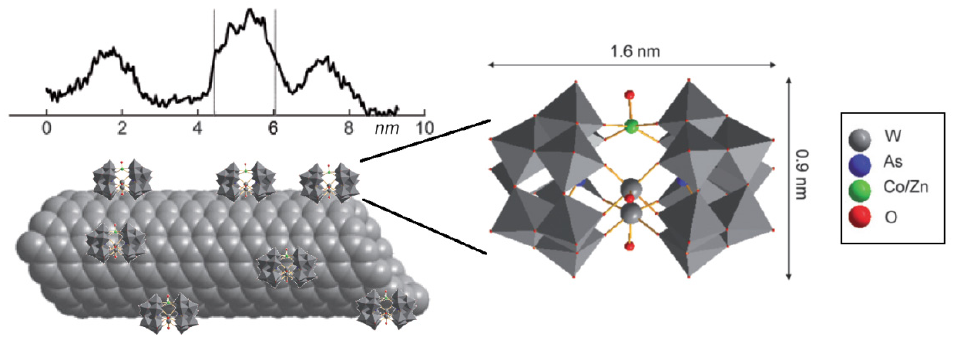
Figure 4. Structure of magnetic metal polyoxometalate (MPOM) cluster attached to CNTs.